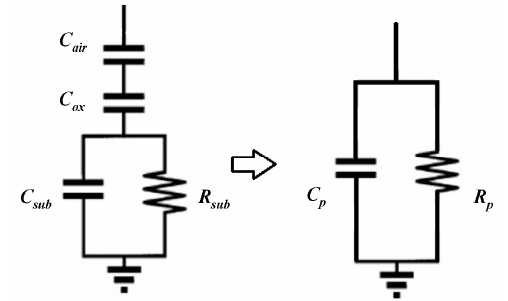
Figure 3. The simplified parallel branch of the π model.